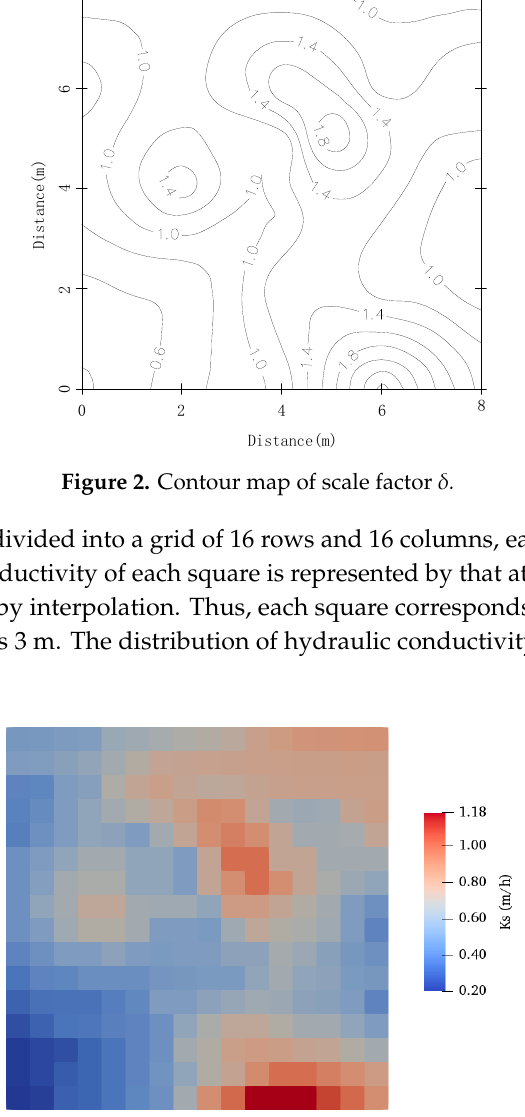
Figure 3. The distribution of hydraulic conductivity.